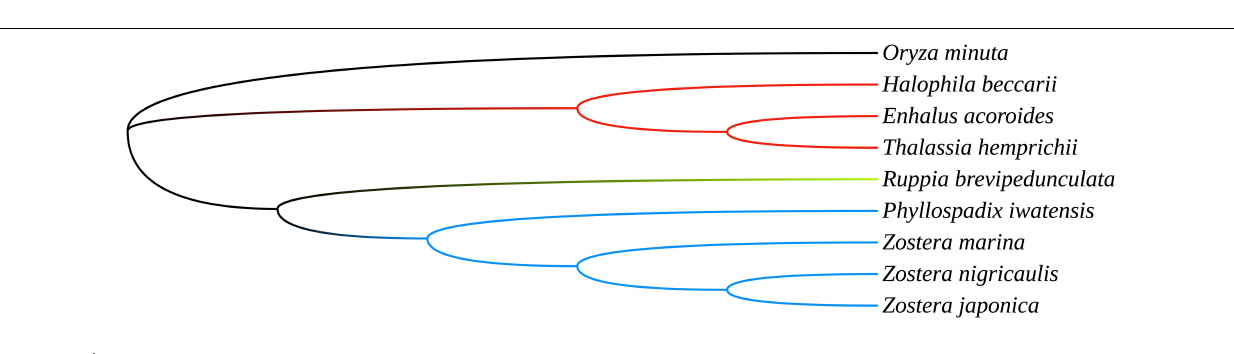
FIGURE 5 | The ML tree of seagrasses based on all shared plastid coding genes.